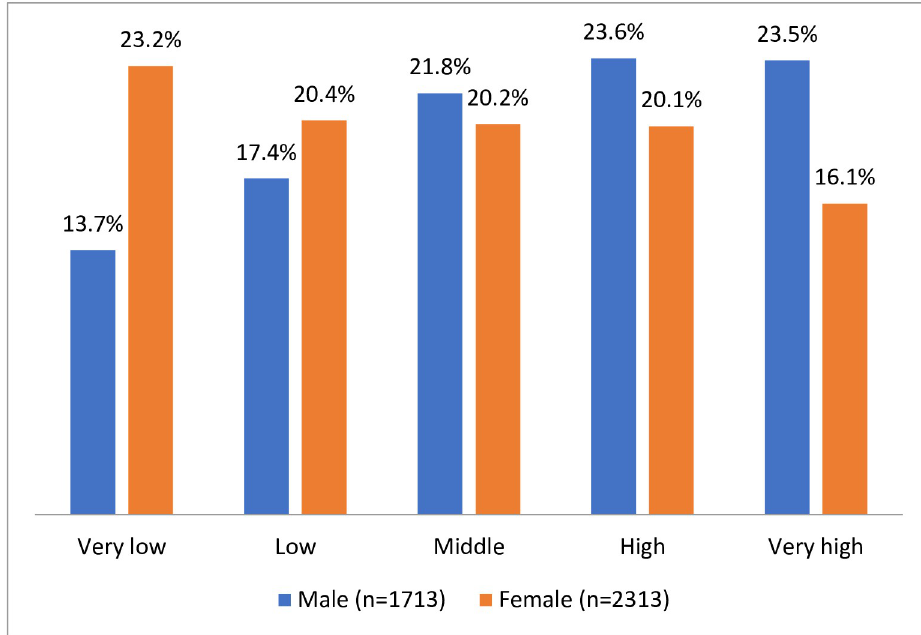
Fig 3. Socioeconomic status of population in the cohort of Bandar Kong.